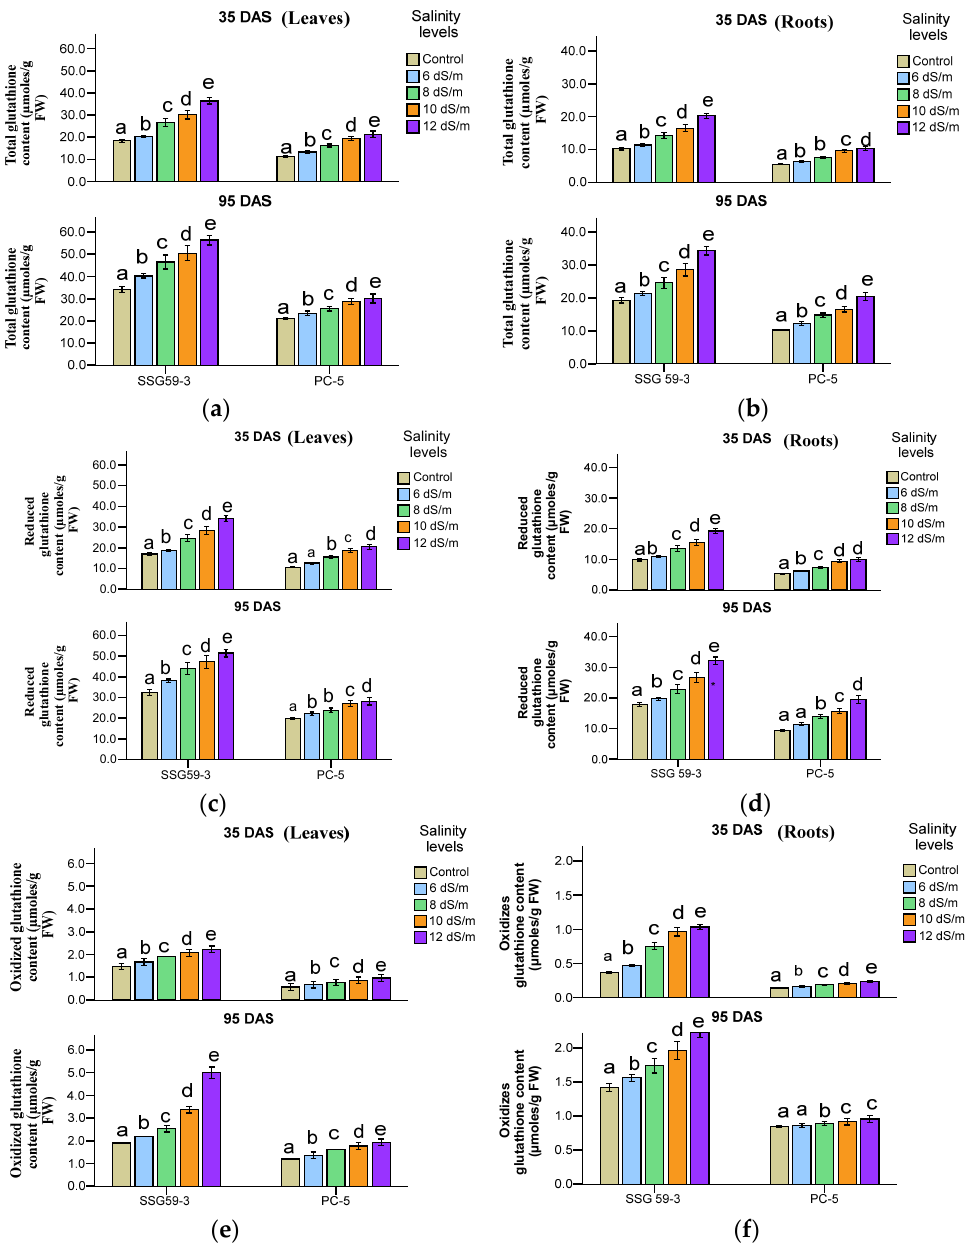
Figure 8. Effect of salt stress on total glutathione ( a , b ), reduced glutathione (GSH, ( c , d ), and oxidized glutathione (GSSG, ( e , f )) of sorghum genotypes at 35 and 95 DAS. Post hoc comparisons of the means were performed using Tukey’s HSD test at p < 0.05; different letters ( a–e ) indicate significant differences among treatments within each genotype.